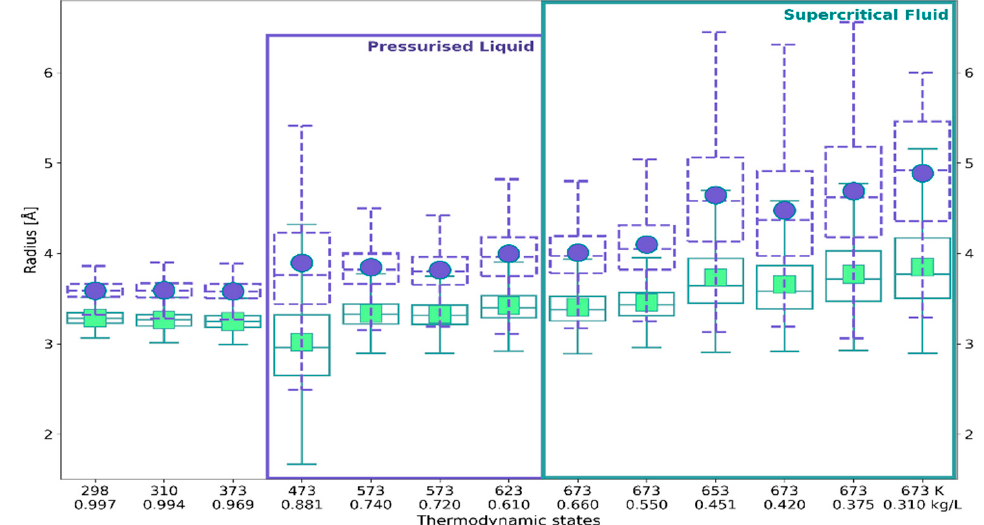
Figure 6. Box-and-whiskers plots displaying median, 1st and 3rd quartiles, minimum (bottom whisker), maximum (upper whisker), and means (points) of statistical distributions of cage radius R (circles, dashed contours) and face-weighted radius R w (squares, solid